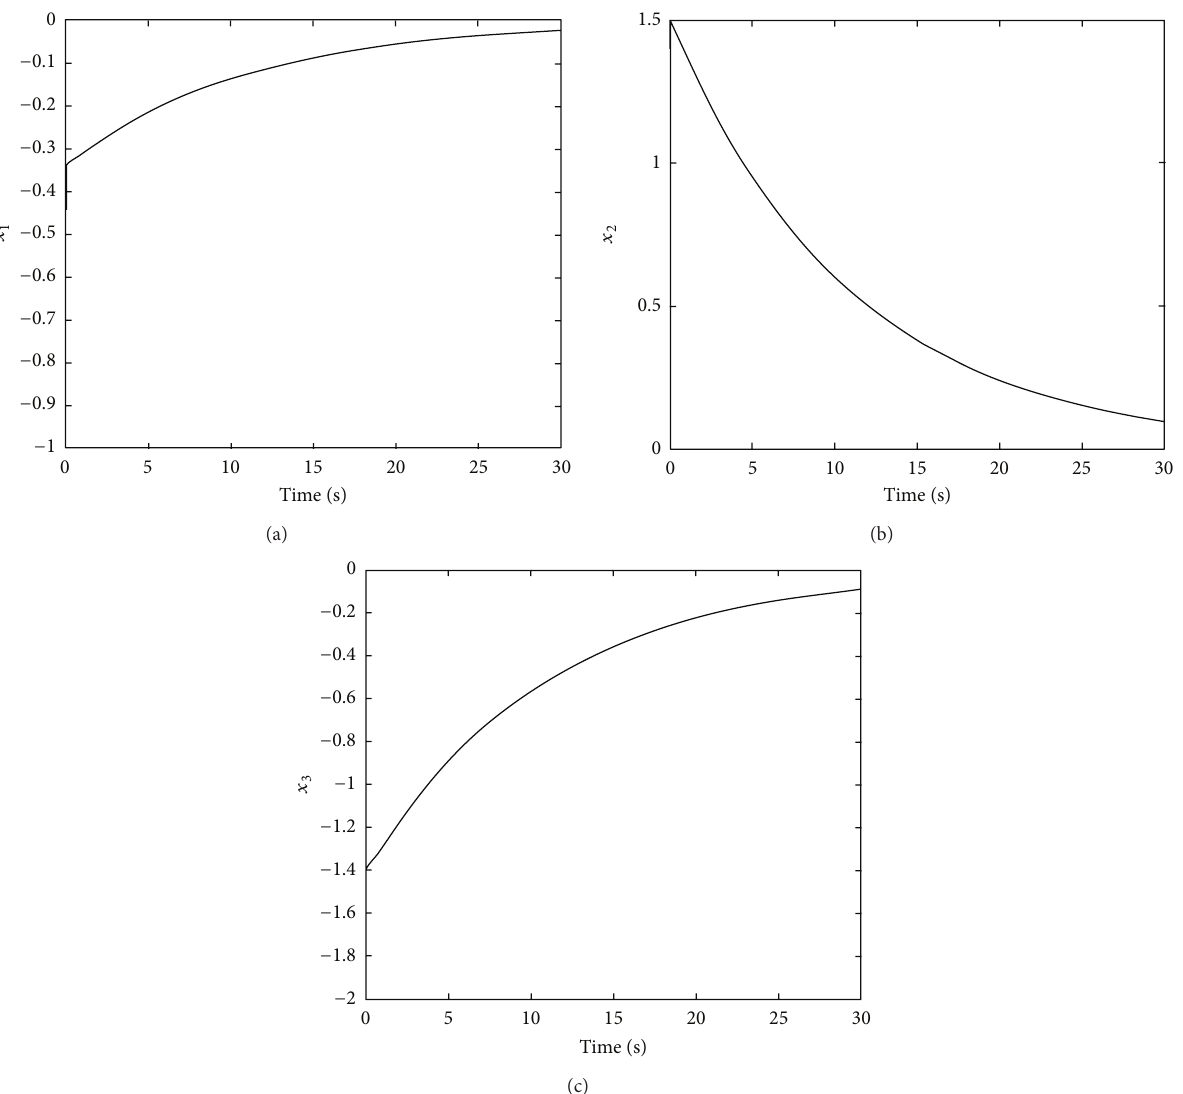
Figure 2: (a) State response for 𝑥 1 . (b) State response for 𝑥 2 . (c) State response for 𝑥 3